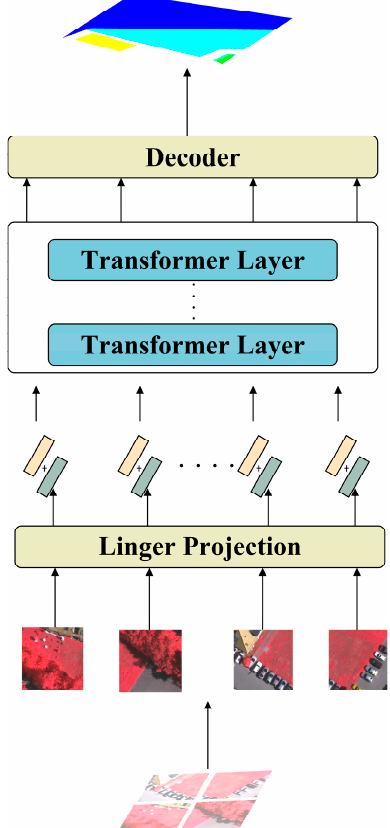
Figure 3. SETRnet structure.